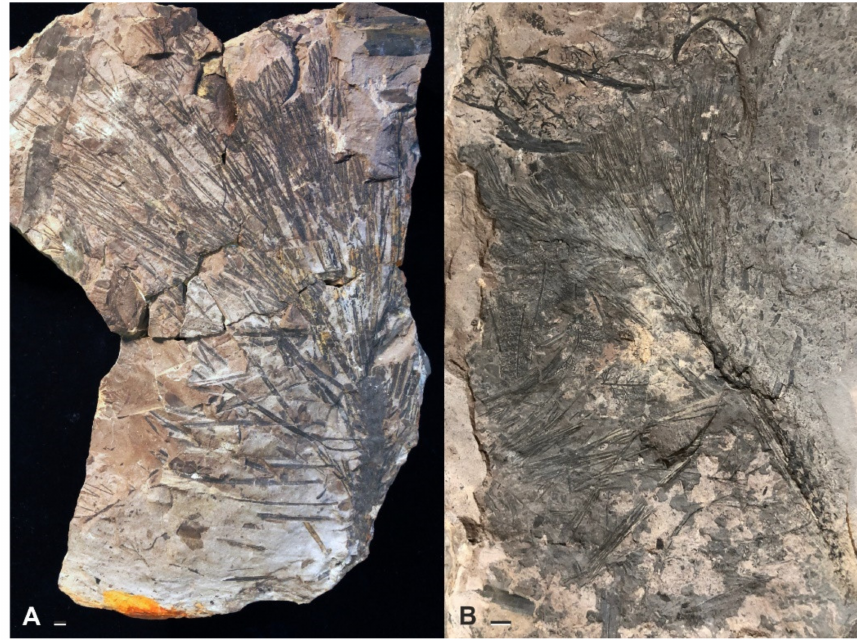
Figure 16. Plant remains from the Zwickau Basin, central Germany: Dicranophyllum sp. showing bifurcating, lineal, relatively narrow long leaves attached to axes with spirally arranged leaf-cushions; ( A )—Zwickau-Cainsdorf, MfNC F14318; ( B )—Oelsnitz, MfNC F14317; scale bars: 5 mm. Gard Basin (C é vennes),